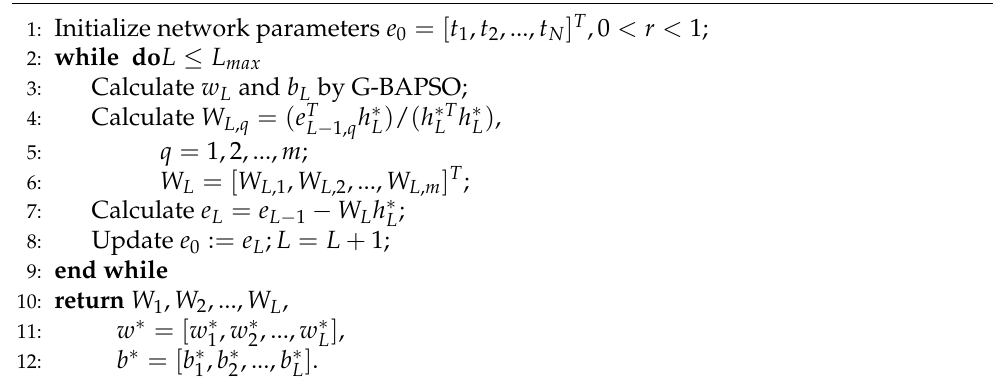
Algorithm 2 The G-BAPSO-SC